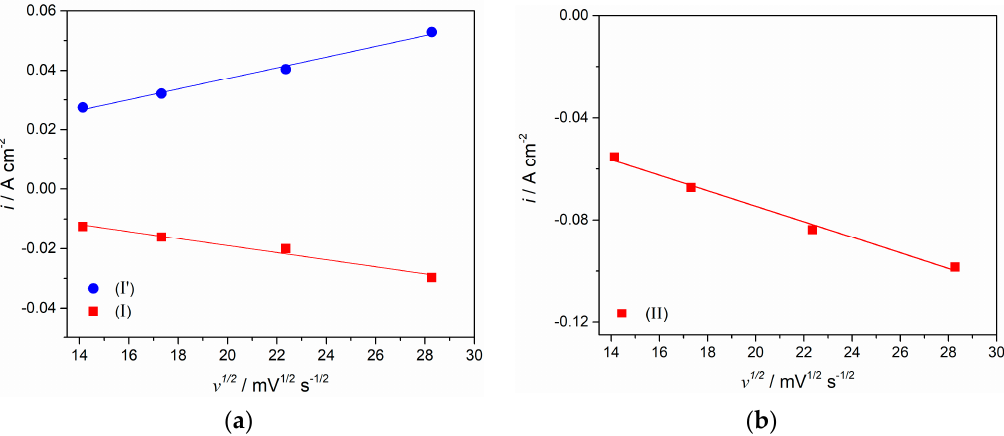
Figure 5. Cathodic and anodic peak currents density vs. the square root of the scan rates derived from Figure 3c; ( a ) of peaks (I/I’) and ( b ) of peak (II).